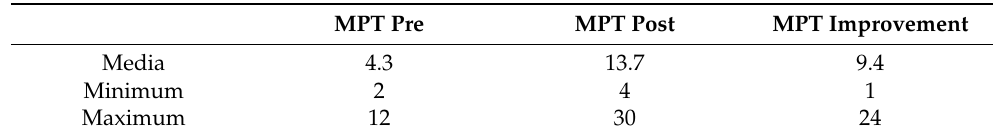
Table 1. Comparison of maximum phonation time MPT (seconds) pre and post-modified Montgomery thyroplasty.